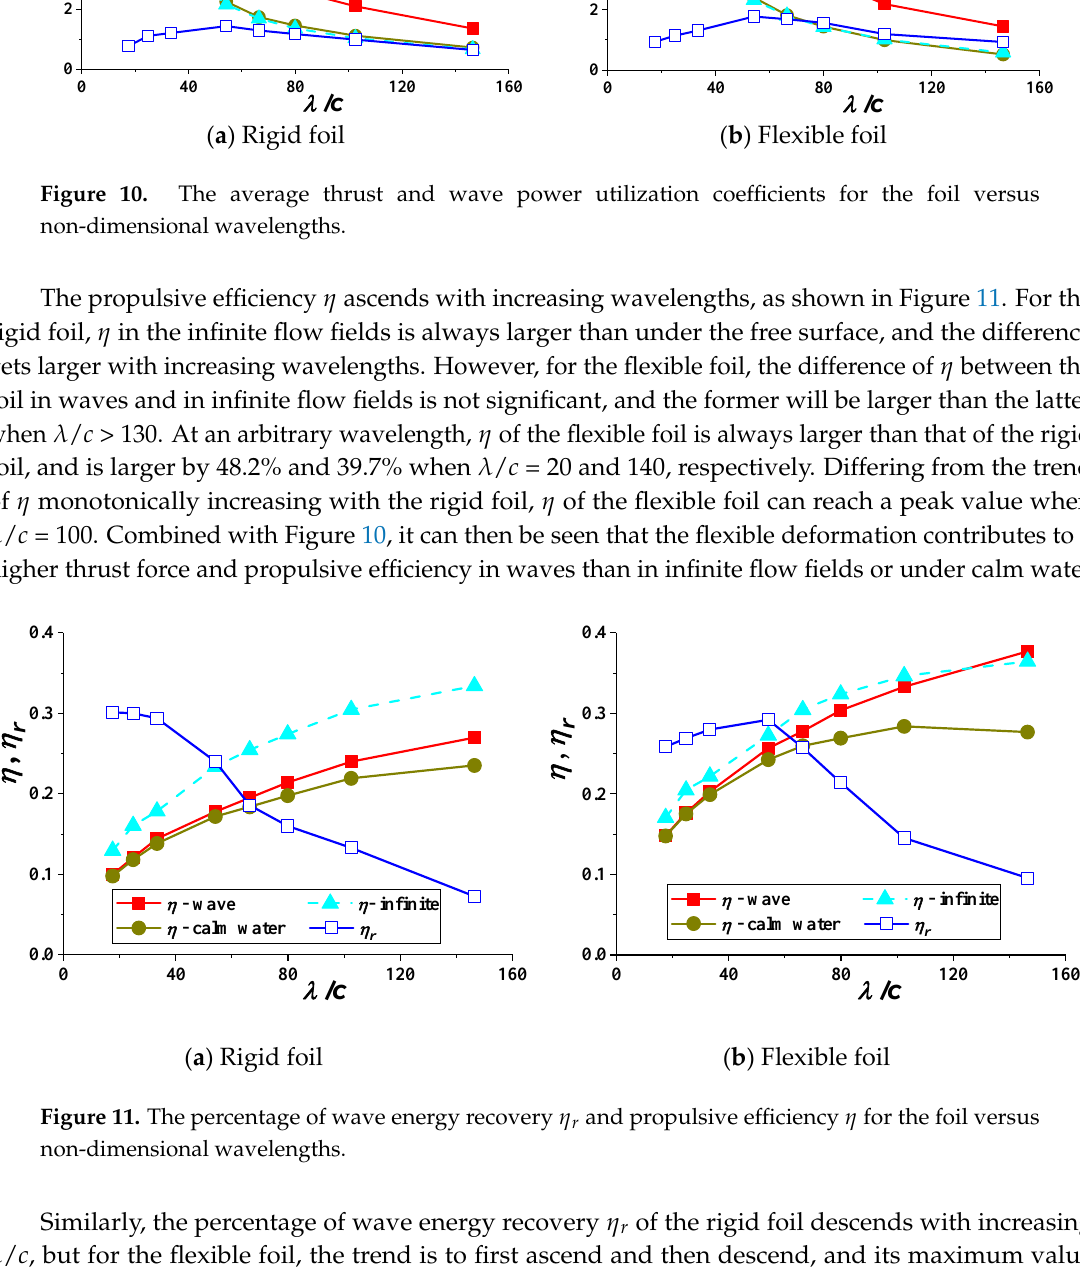
Figure 10. The average thrust and wave power utilization coefficients for the foil versus non- Figure 10. dimensional wavelengths. non-dimensional wavelengths.